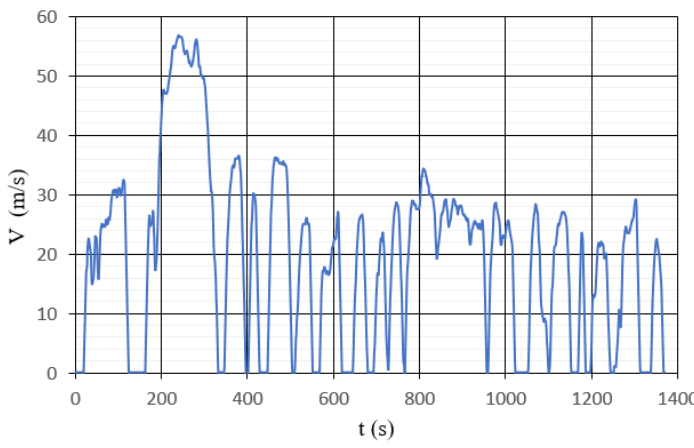
Figure 17. Vehicle speed under the UDDS. 350400 300 Figure 18. Voltage variations during the UDDS drive cycle. Figure 19. Output power of the FCS, battery and ultra-capacitors. 50100150200250